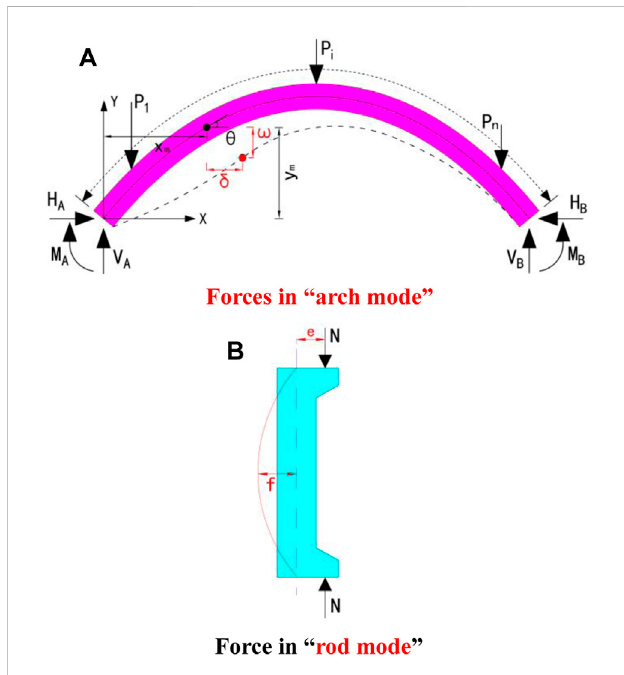
FIGURE 1 Stresscharacteristicsofthe “ archmode ” and “ rodmode ” : (A) Forces in “ arch mode ” ; (B) Force in “ rod mode “